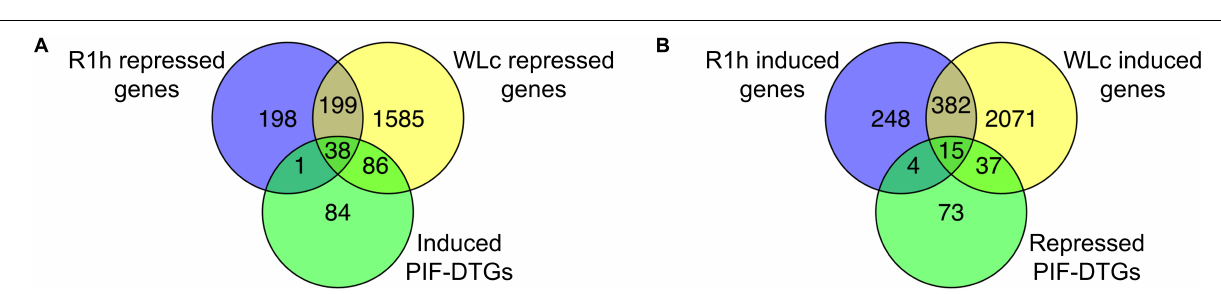
R1h vs. D and r = 0.8 for WLc vs. D), for genes with a